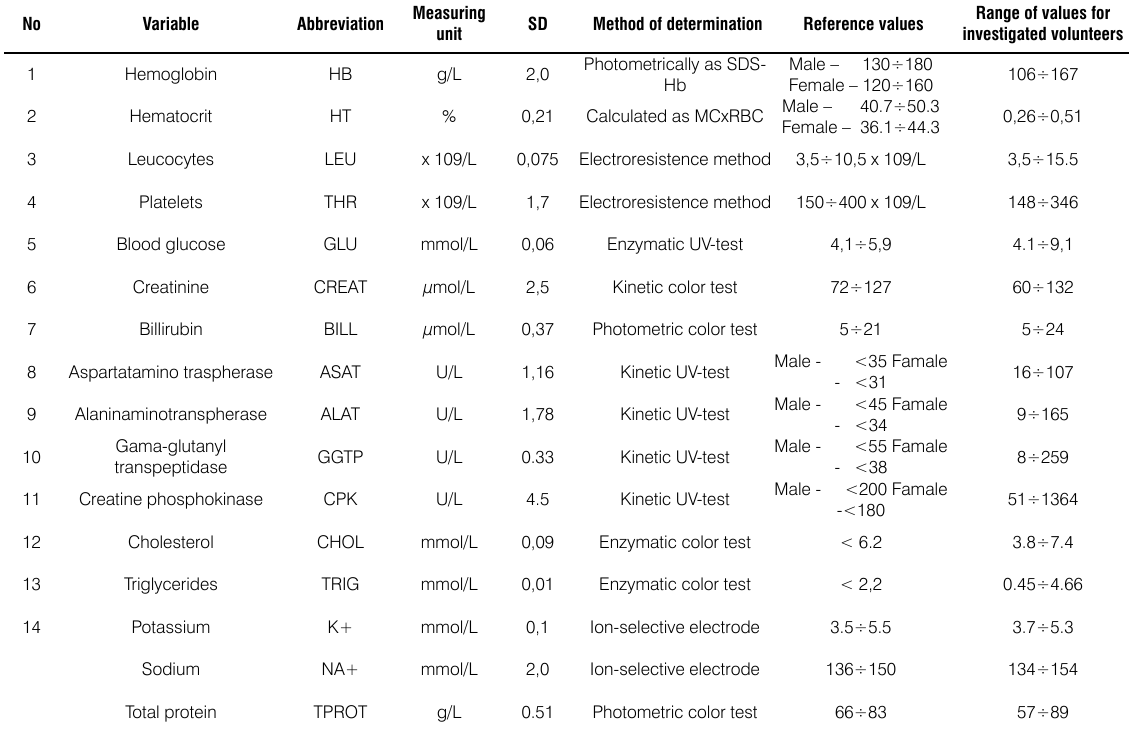
Table 2. Clinical/biochemical variables with their reference values, methods of determination and range of values for investigated